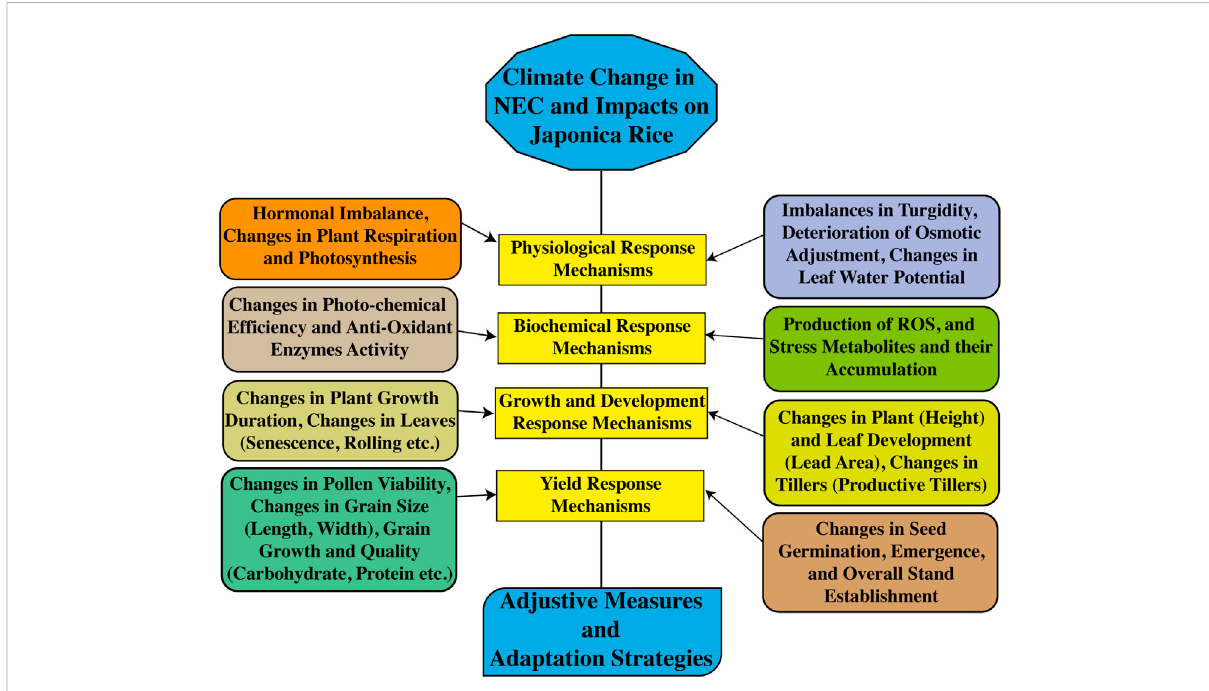
FIGURE 7 Roadmap for sustainable productionof Japonica rice in NEC through an assessment of response mechanisms, thereby disseminating adjustive